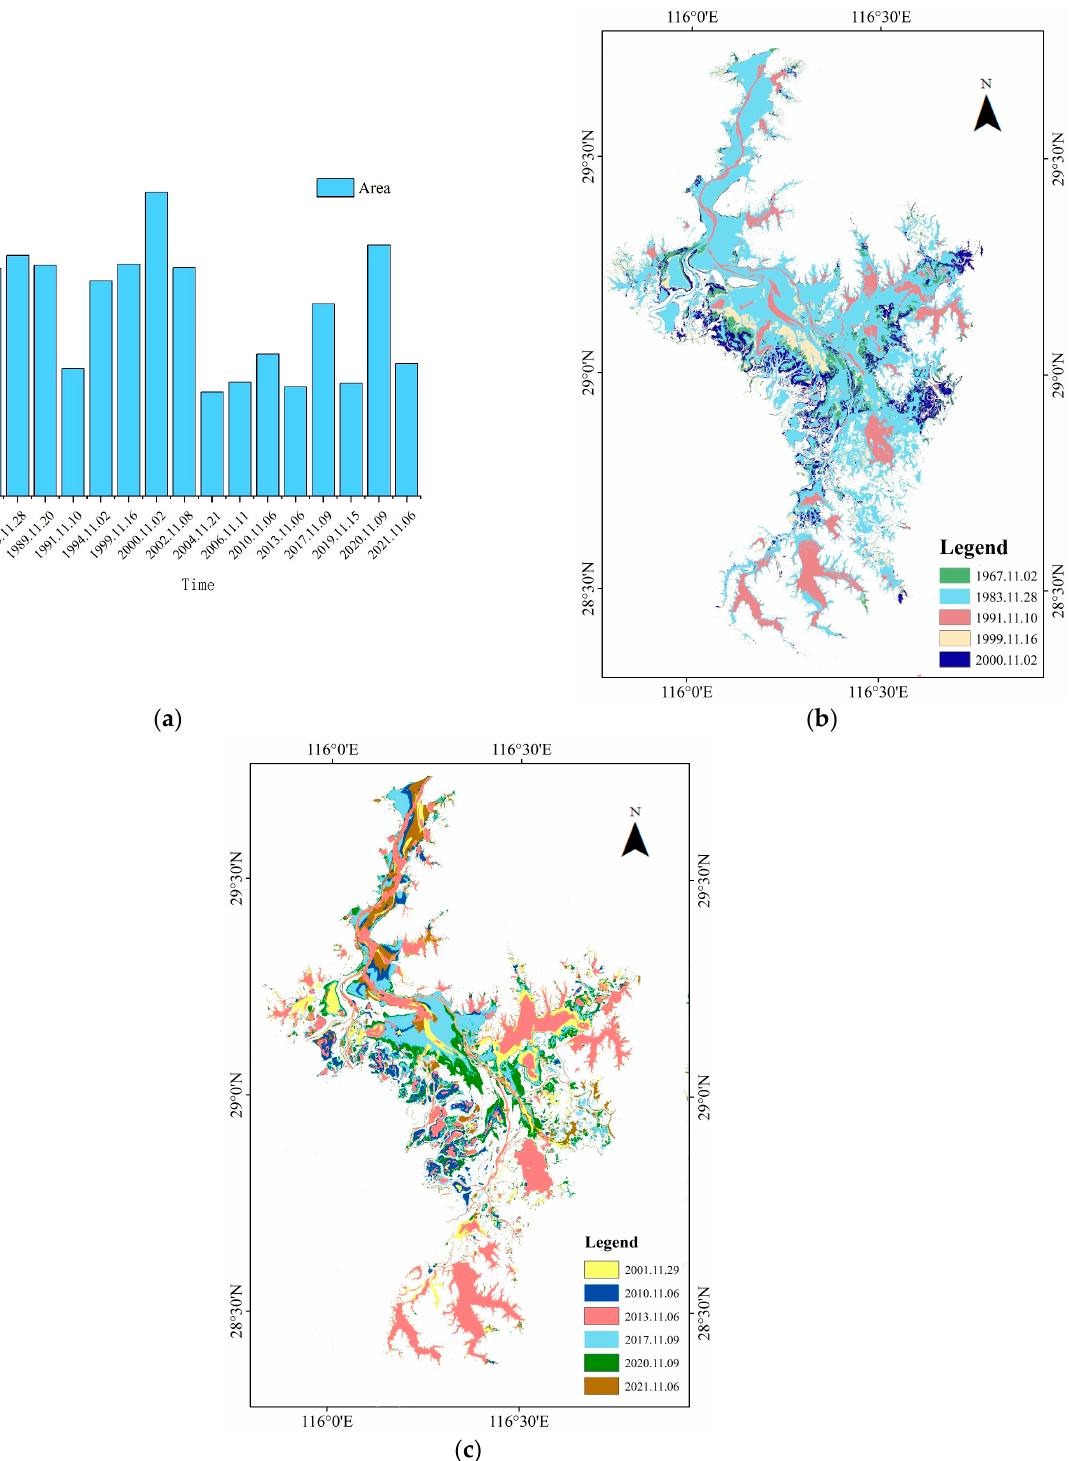
Figure 13. Comparison of lake water area during the early dry season: ( a ) description of lake water area at the end of the dry season; ( b ) comparison of lake water area extraction results at the end of dry season. ( c ) Comparison of lake water area extraction results at the end of dry season.